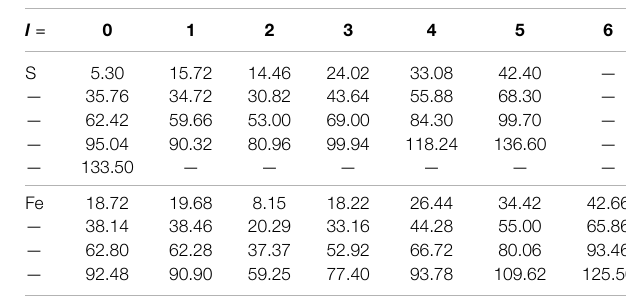
TABLE 1 | Energy parameters (unit: Rydberg) of high-energy local orbitals (HLOs) usedinpyriteFeS 2 correspondingtoHLOsparameters n LO (cid:2) 4, Δ l LO (cid:2) 4forFe and S. Those for marcasite are essentially the same with difference by 0.02 Ry at most in each element and l